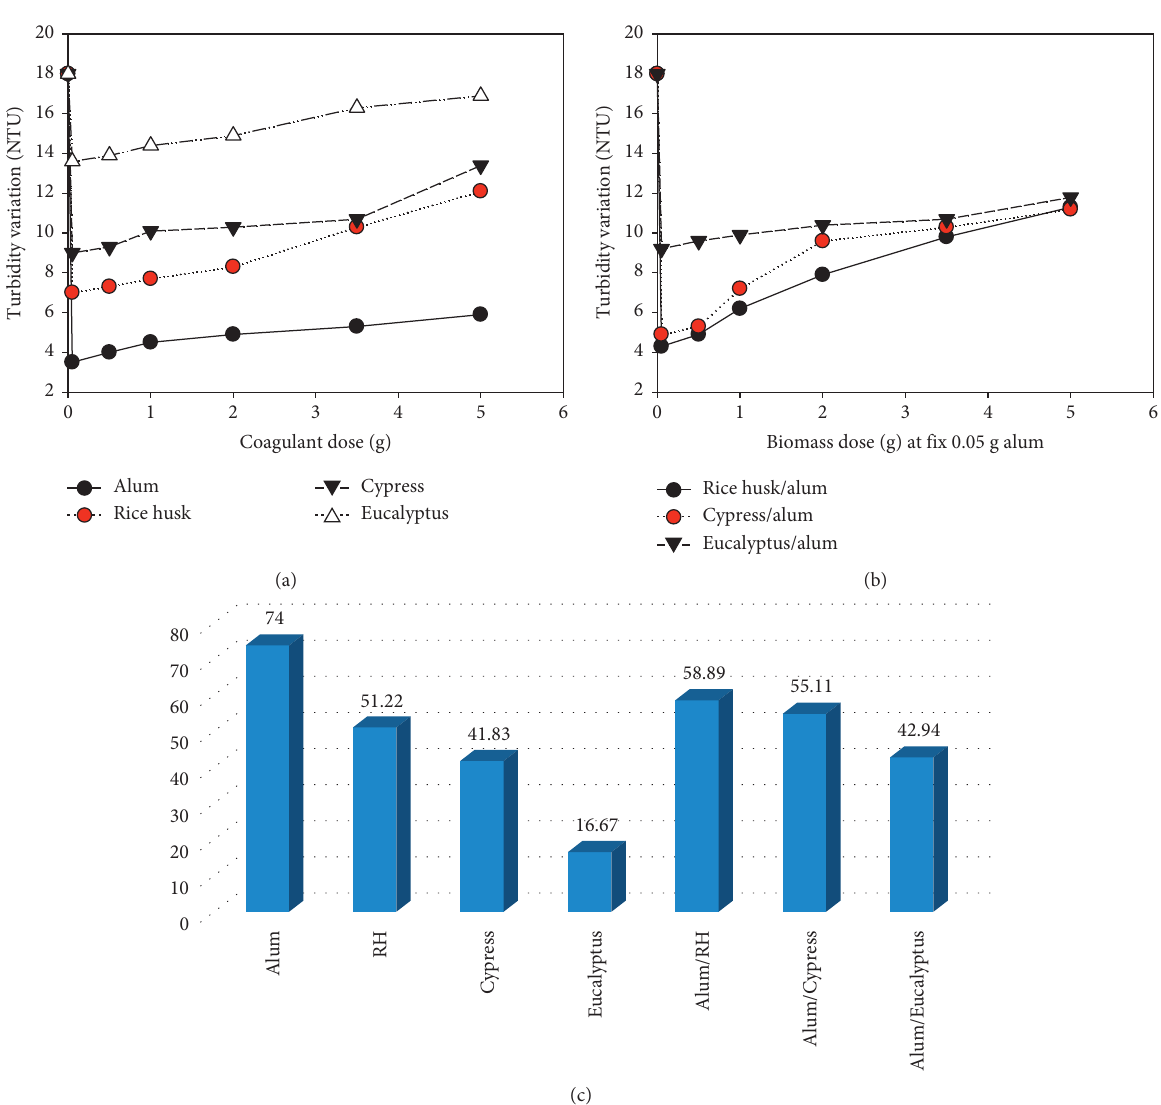
Figure 6: Variation of turbidity of well water with (a) individual, (b) mixed coagulants, and (c) coagulation activities